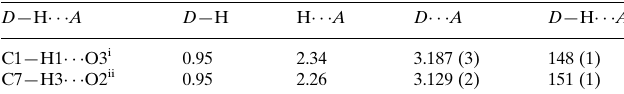
Hydrogen-bond geometry (A˚ , (cid:2)